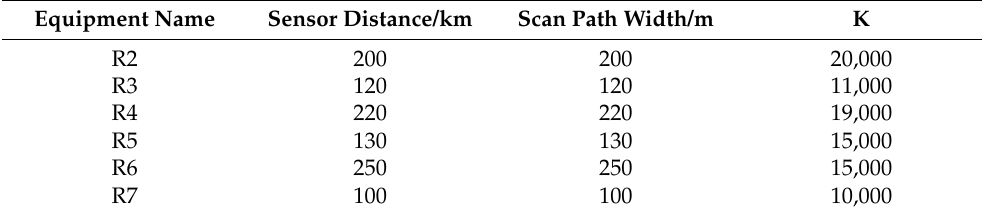
Table 4. Attributes of the red side’s sensor nodes.